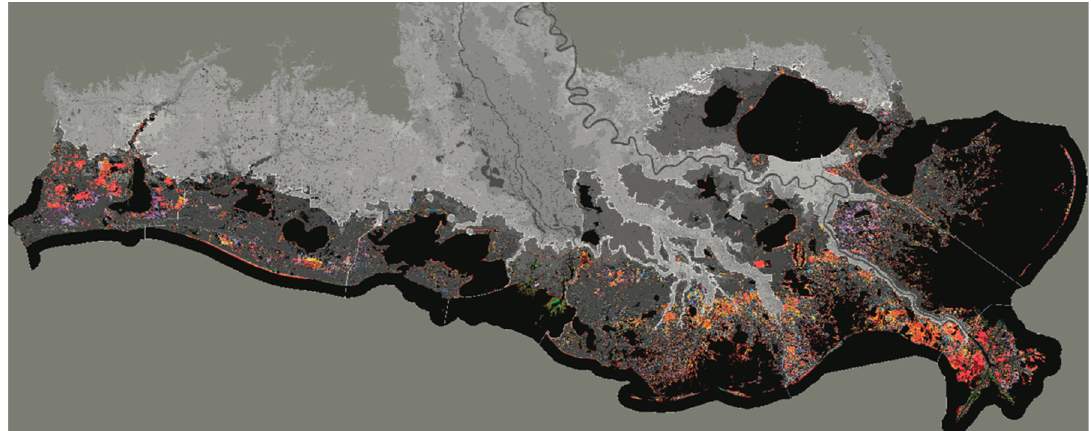
Figure 6. Wetland loss in coastal Louisiana from 1932 to 2016. Red and yellow areas have high land loss rates. Note that land loss is low in the central coast and in the northeastern flank of the delta. (Source: [33,34] The map can be downloaded at https: // pubs.usgs.gov / sim / 3381 / sim3381.pdf for detailed examination of specific areas of change. See also https: // pubs.er.usgs.gov / publication / sim3381).